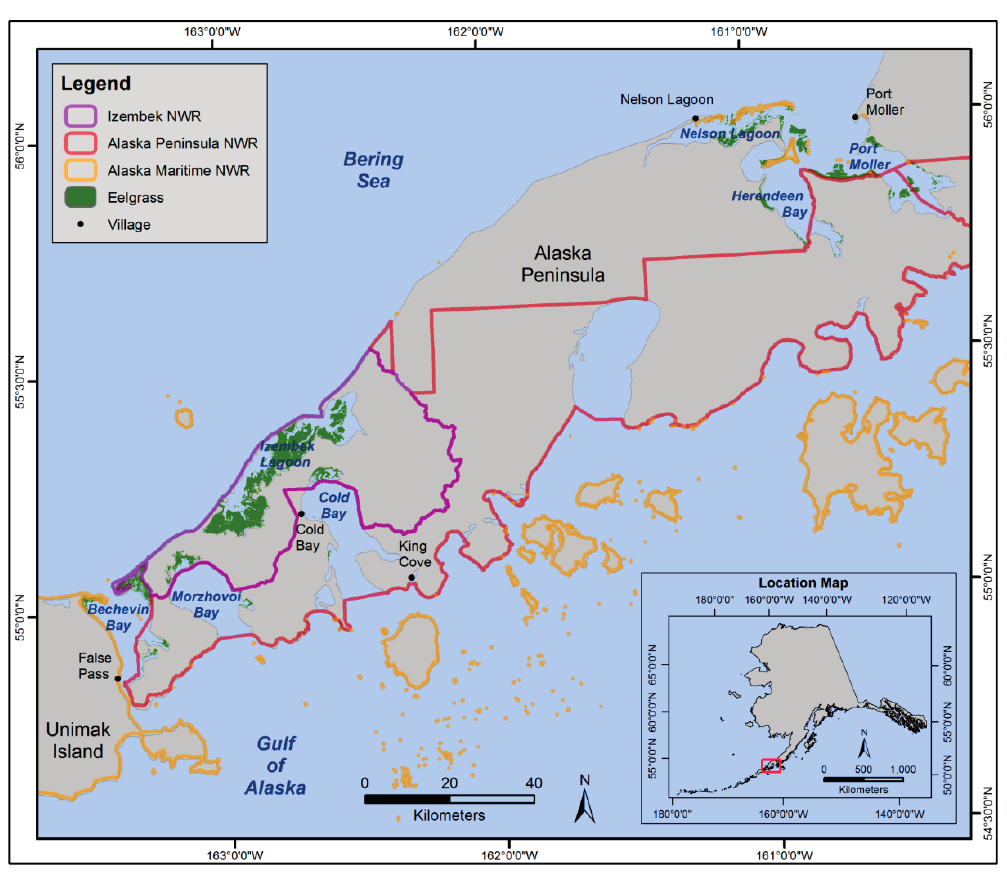
Figure 1. Location of study area, mapped eelgrass and National Wildlife Refuge (NWR) lands on the lower Alaska Peninsula,